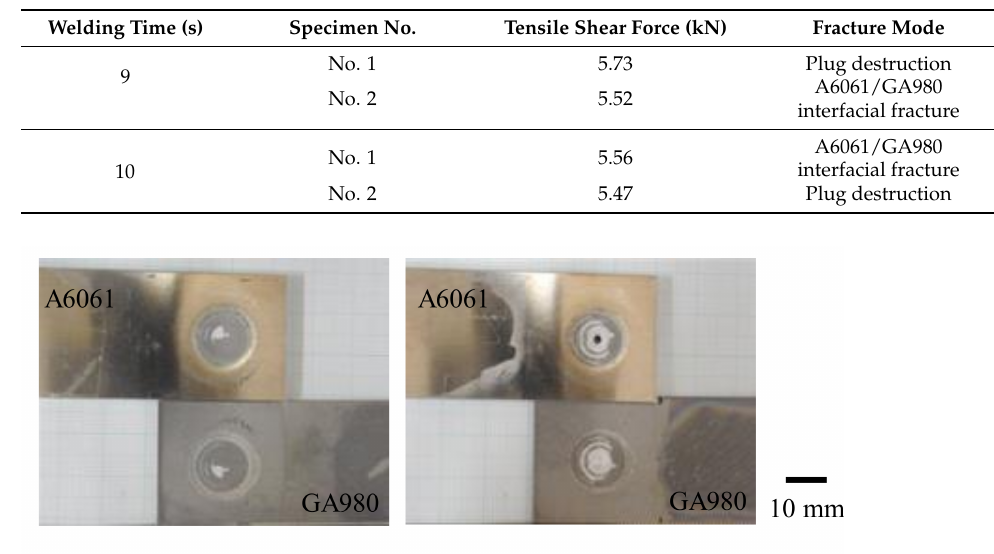
Table 2. Results of the tensile shear test.